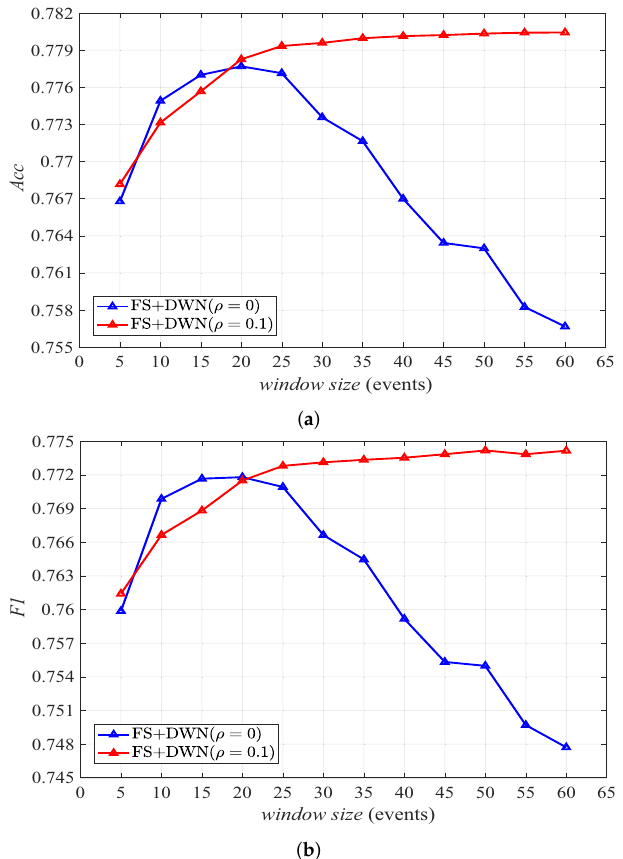
Figure 8. Results of employing FS +DWN with ρ = 0 and ρ = 0.1, respectively. ( a ) Accuracy. ( b ) F1 score.